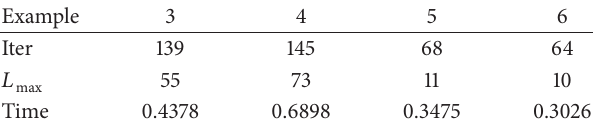
Table 3: 𝛼 = 0.5 ; the strategies in Section 3 are all